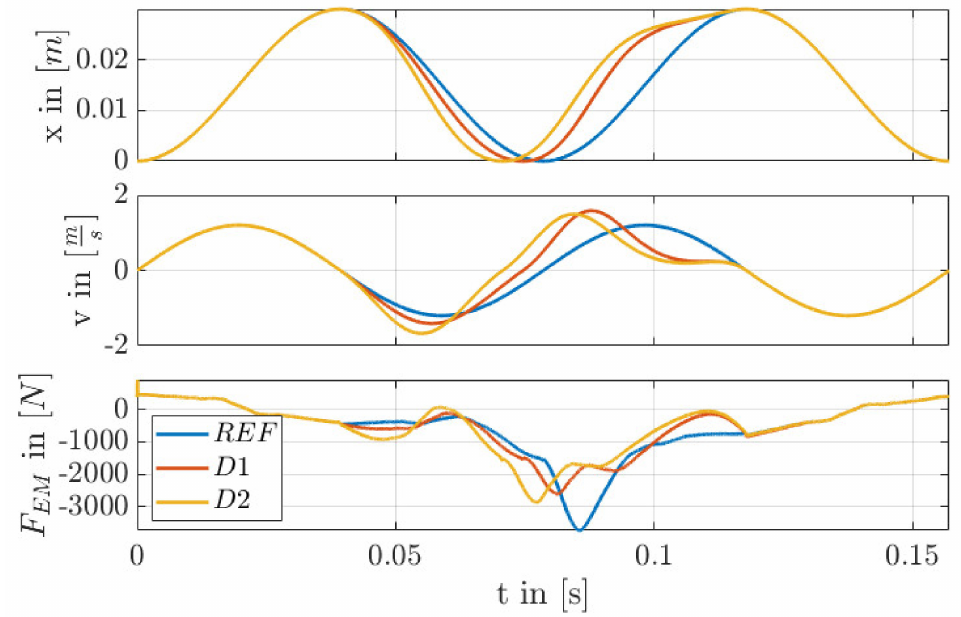
Figure 32. Comparison of trajectories REF, D1 and D2 related to the energy conversion of the electrical machine: illustration of the stroke, velocity and electric machine force depending on